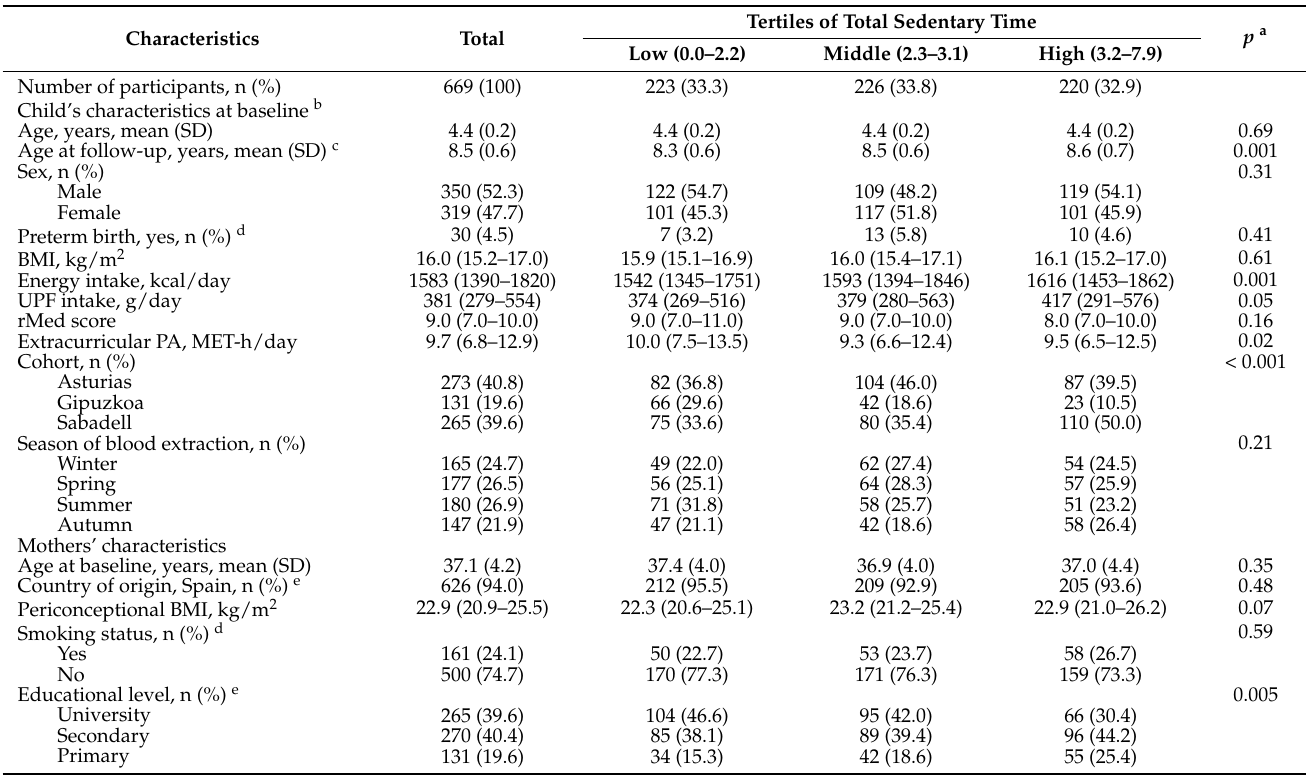
Table 1. Characteristics of mother–child pairs from the INMA study according to total sedentary time tertiles (h/day) at the age of 4 years.